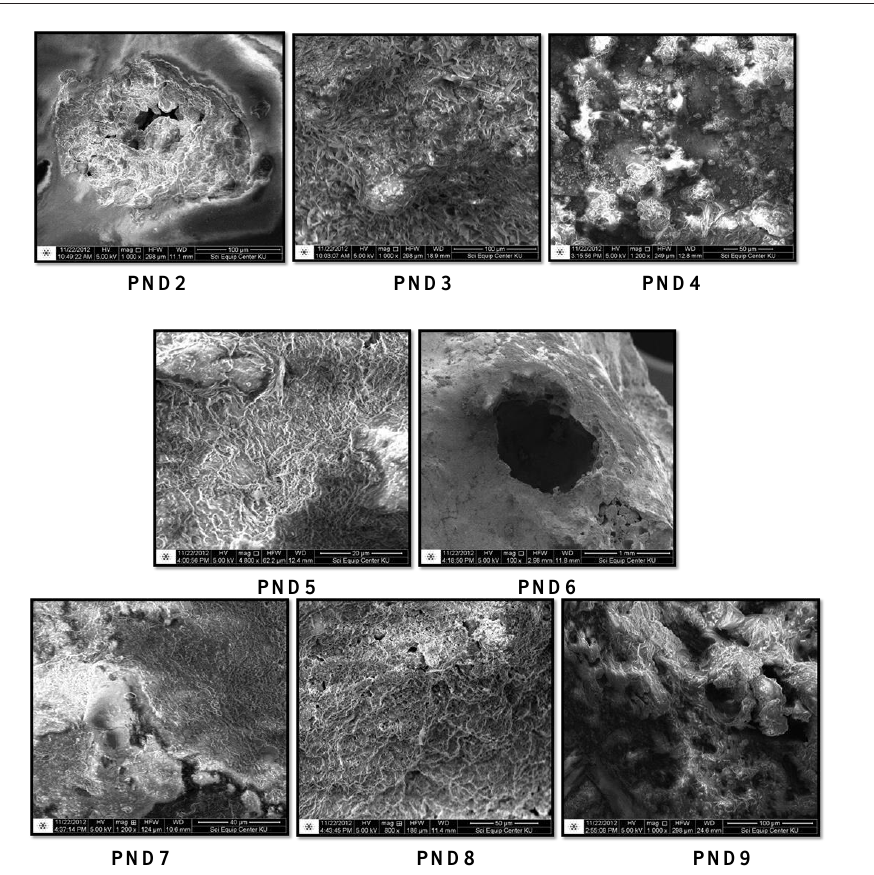
Fig. 3. Morphologies of samples of Phra Kru Nadune